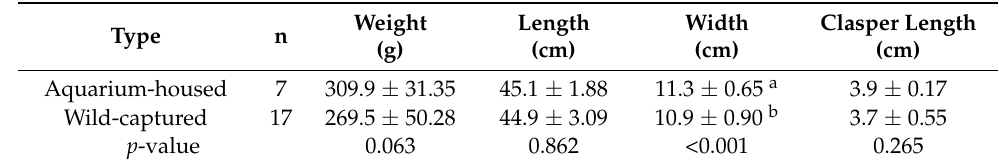
Table 1. Biometric comparison for aquarium-housed and wild captured small-spotted catshark ( Scyliorhinus canicula ) males. Data are expressed as the mean ± standard deviation.